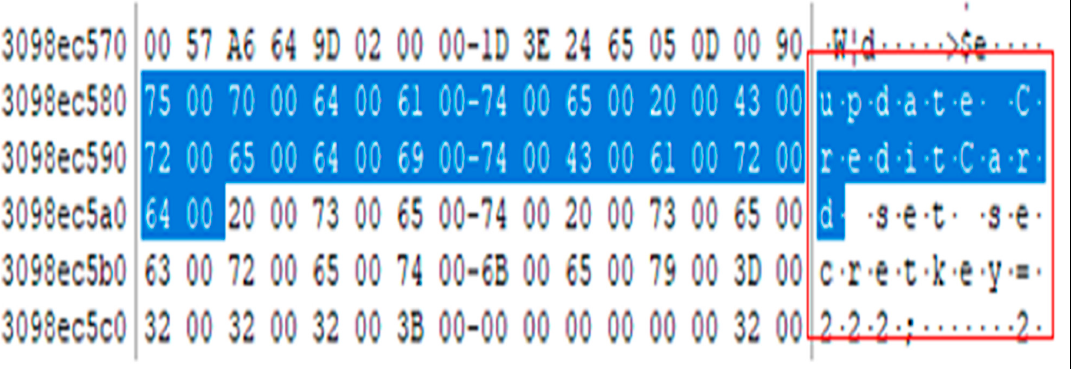
Figure 15. Analyzing acquired